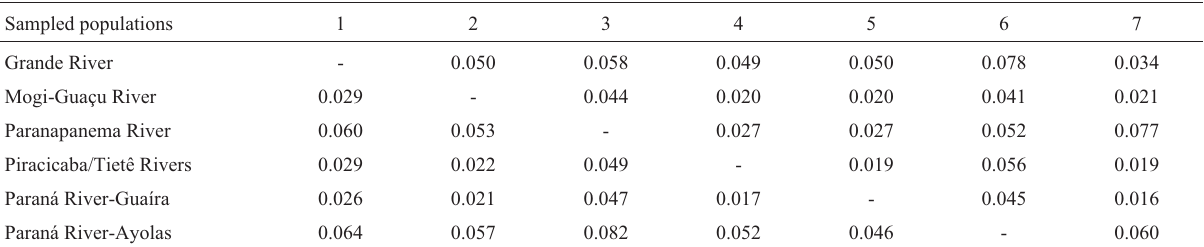
Table 2 - Nucleotide diversity among sampled populations of L. elongatus (above the diagonal, columns 1-6) and average genetic distances, based on nucleotide divergence, within (column 7) and among distinct populations of L. elongatus (below the diagonal). Sampled